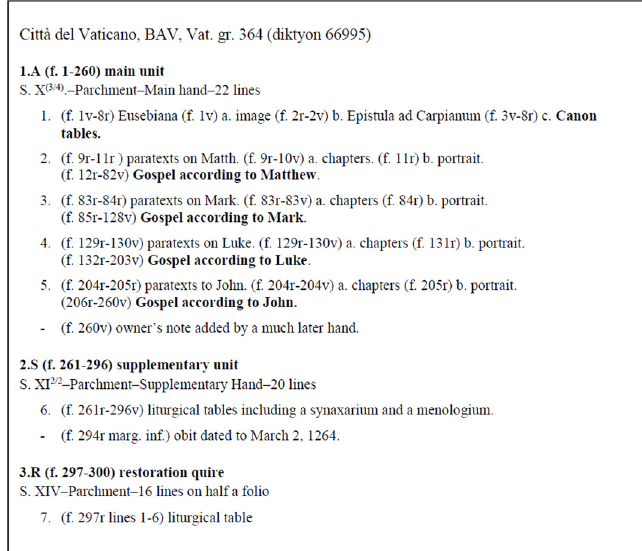
Figure 4. Abbreviated Description of Vat. gr. 364